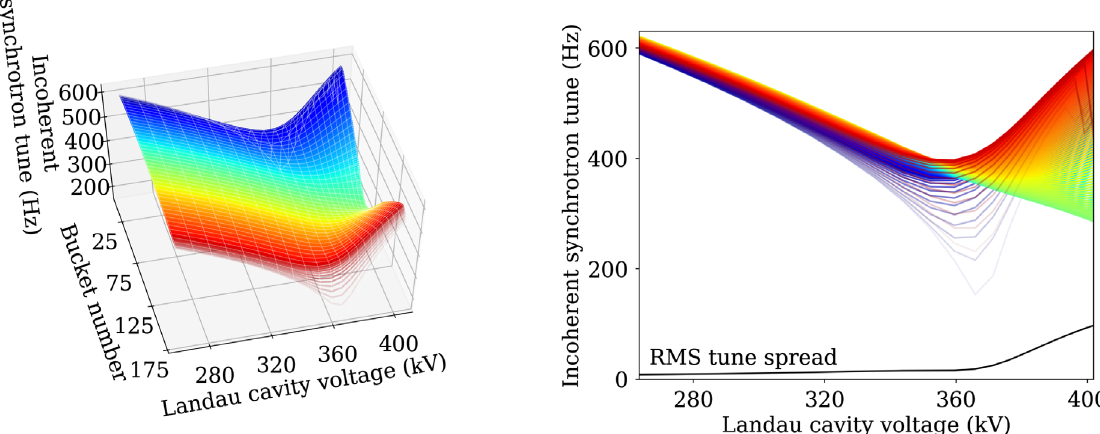
FIG. 11. Incoherent synchrotron tune spread within the bunch train as a function of Landau cavity voltage: 3D plot on the left and projection on the